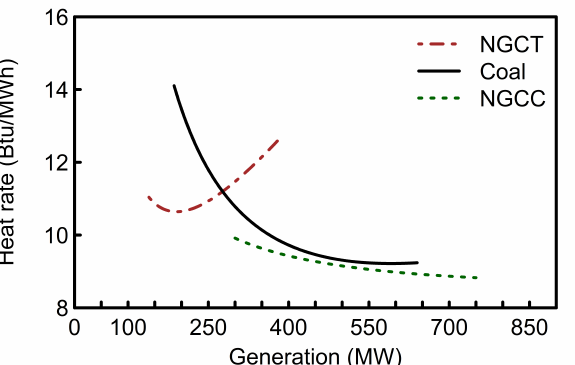
Figure 3. Example heat rate curve for natural gas combustion turbine (NGCT), coal, and natural gas combined cycle (NGCC) thermal generators considered in this study.